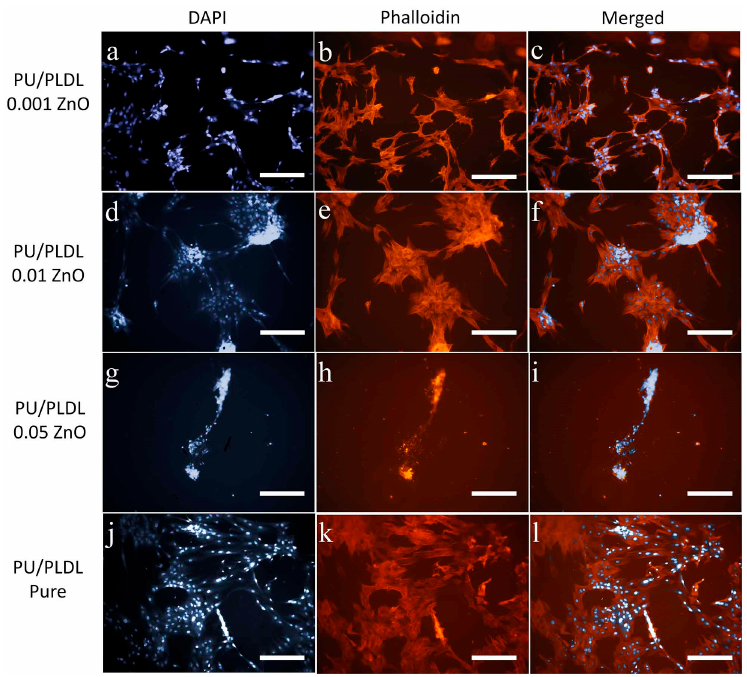
Figure 5. Olfactory ensheathing cells cultured on different experimental polymers stained histochemically for nuclei (DAPI, a , d , g , j ), and actin (phalloidin, b , e , h , k ); cell clusters marked with arrowheads; c , f , i , l —merged pictures; magnifications 100×, scale bar = 200 µm.